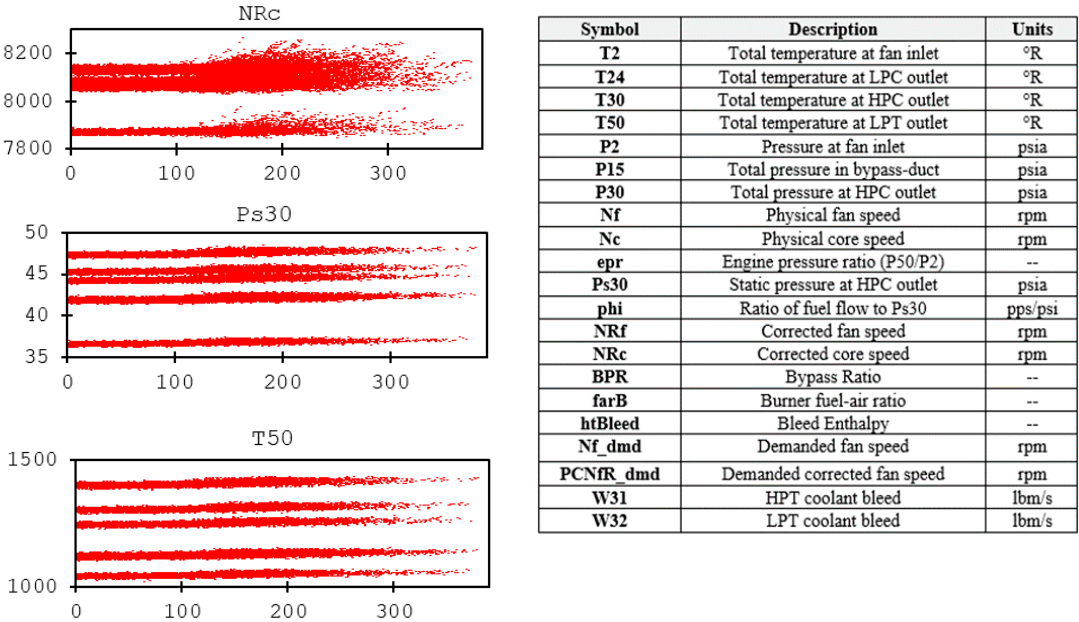
Figure 6. Example of Sensor signals (NRc and Ps30) and all feature descriptions.